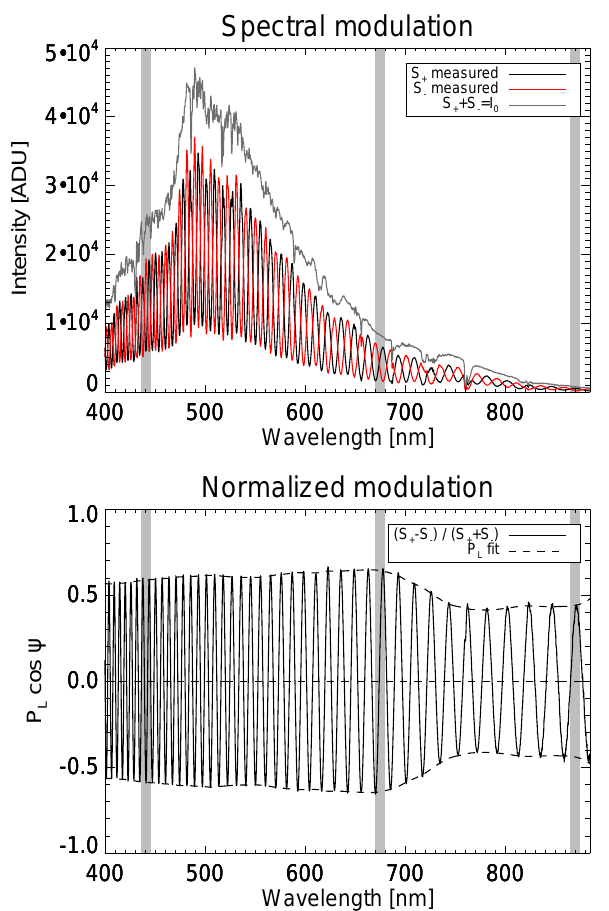
Figure 1. Top: the groundSPEX instrument measures the two per- pendicularly modulated spectra S + and S − simultaneously. The de- Figure 1. Top. The groundSPEX instrument measures the two per- gree ( P L ) and angle ( φ L (ψ ) of linear polarization are encoded as pendicularly modulated spectra S + and S simultaneously. The de- the relative amplitude and phase of the modulation pattern, respec- − gree ( P L ) and angle ( φ L ( ψ ) ) of linear polarization are encoded as tively. The sum of the two modulated spectra is the intensity spec- the relative amplitude and phase of the modulation pattern, respec- trum I 0 at full resolution. Bottom: curve fits of P L cos ψ to the nor- malized modulation in a moving window provide the spectral po- tively. The sum of the two modulated spectra is the intensity spec- larization information. Note the decrease in polarization at 550nm trum I 0 at full resolution. Bottom. Curve fits of P L cos ψ to the nor- and above 700nm, due to the increase in the albedo of grass, called malized modulation in a moving window provide the spectral po- the green bump and red edge, respectively. Note also that the strong larization information. Note the decrease in polarization at 550 nm oxygen A absorption band around 765nm is clearly visible in the and above 700 nm, due to the increase in the albedo of grass, called intensity spectrum (top plot), whereas it has no impact on the nor- green bump and red edge, respectively. Note also that the strong malized modulation pattern (bottom plot). The grey vertical bands Oxygen A absorption band around 765 nm is clearly visible in the indicate the wavelength bins that have been used for retrieving the intensity spectrum (top plot), whereas it has no impact on the nor- aerosol parameters, matching the spectral bands of the colocated malized modulation pattern (bottom plot). The grey vertical bands AERONET sun photometer, viz. 441, 675, and 870nm, all with a indicate the wavelength bins that have been used for retrieving the full width at half maximum of aerosol parameters, matching the spectral bands of the co-located AERONET sun photometer, viz. 441 , 675 and 870 nm, all with a full width at half maximum of 10 nm.